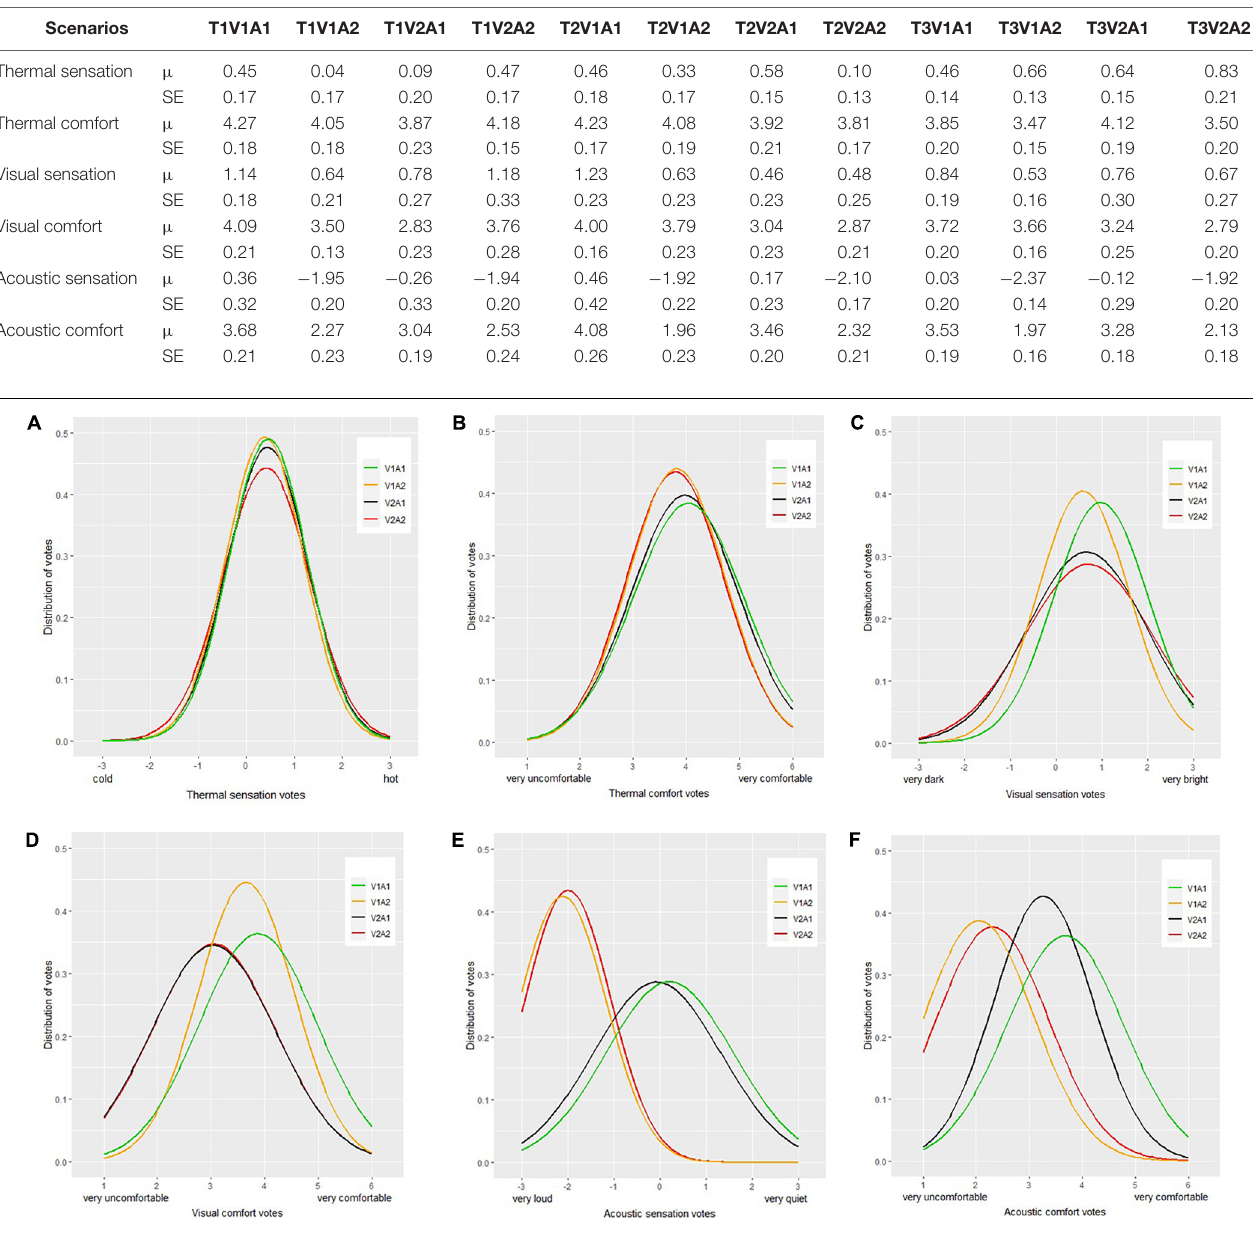
FIGURE 4 | Distribution of the evaluation of thermal sensation (A) and comfort (B) , visual sensation (C) and comfort (D) , and acoustic sensation (E) and comfort (F) of participants.